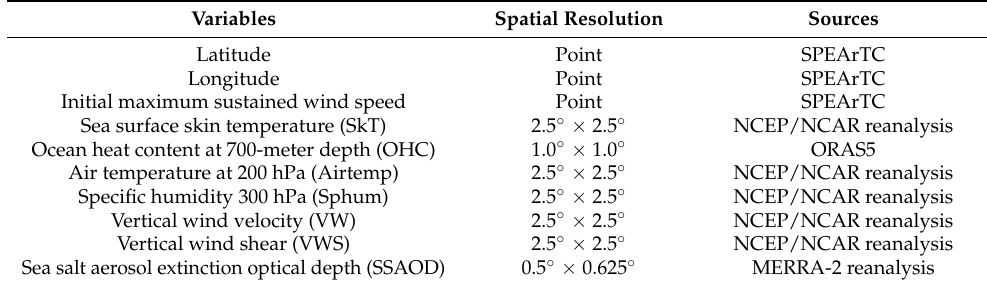
Table 1. Aerosol and geophysical input variables used in the machine learning algorithms. The table includes the spatial resolution (excluding latitude and longitude) and source of each